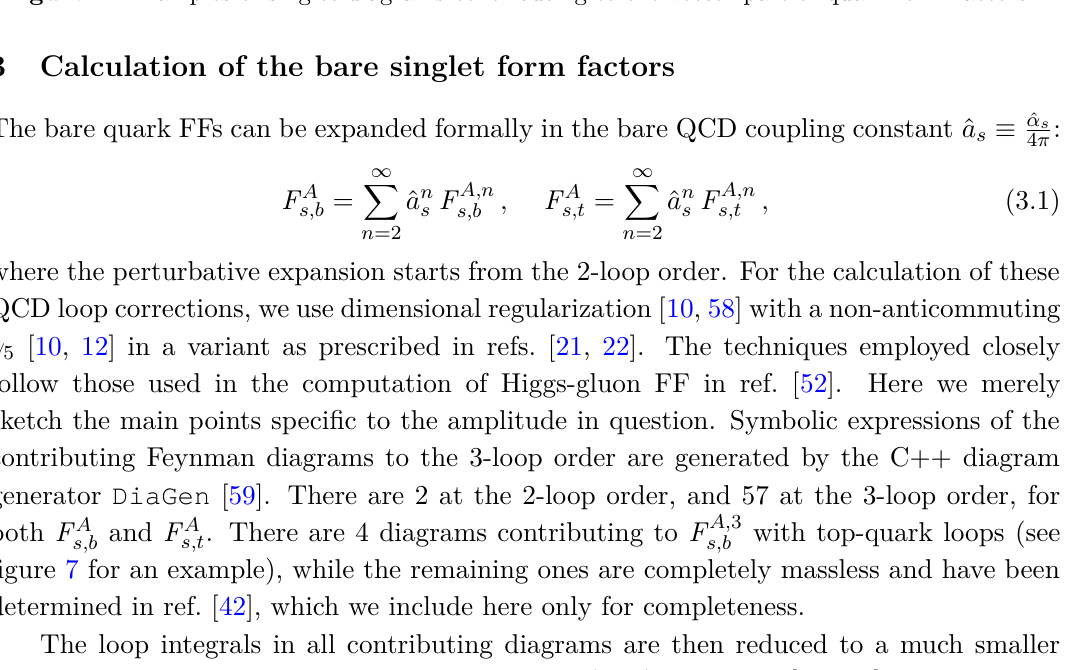
Figure 2 . Examples of singlet diagrams contributing to the vector part of quark form